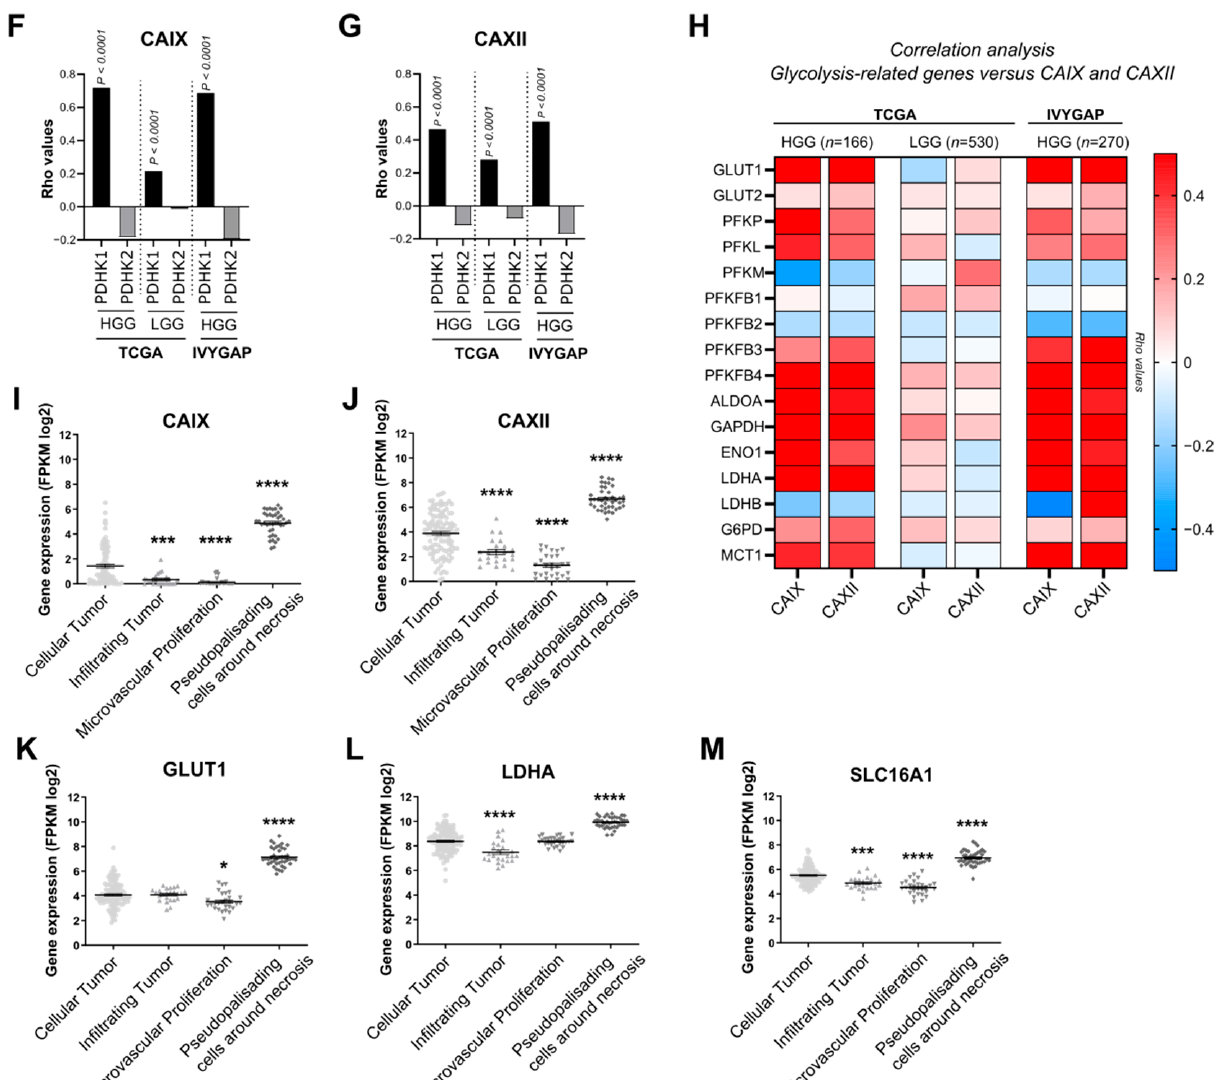
Figure 1. Expression and correlation analysis of PDHK1, PDHK2 and genes involved in glucose metabolism in HGG and LGG. ( A ) Expression levels of PDHK1 in normal tissue, low-grade glioma (LGG) and high-grade glioma (HGG) (TCGA). ( B ) PDHK1 expression levels and localization in HGG tissue (IVYGAP). ( C ) Expression levels of PDHK2 in normal tissue, LGG and HGG (TCGA). ( D ) PDHK2 expression levels and localization in HGG tissue (IVYGAP). ( E ) Correlation analysis of genes involved in glycolysis with PDHK1 and PDHK2 in HGG and LGG from TCGA and HGG from TCGA + IVYGAP. ( F ) Correlation analysis of CAIX with PDHK1 and PDHK2 in HGG and LGG from TCGA and HGG from IVYGAP. ( G ) Correlation analysis of CAXII with PDHK1 and PDHK2 in HGG and LGG from TCGA and HGG (TCGA + IVYGAP). ( H ) Correlation analysis of genes involved in glycolysis with CAIX and CAXII (TCGA + IVYGAP). ( I ) CAIX and ( J )